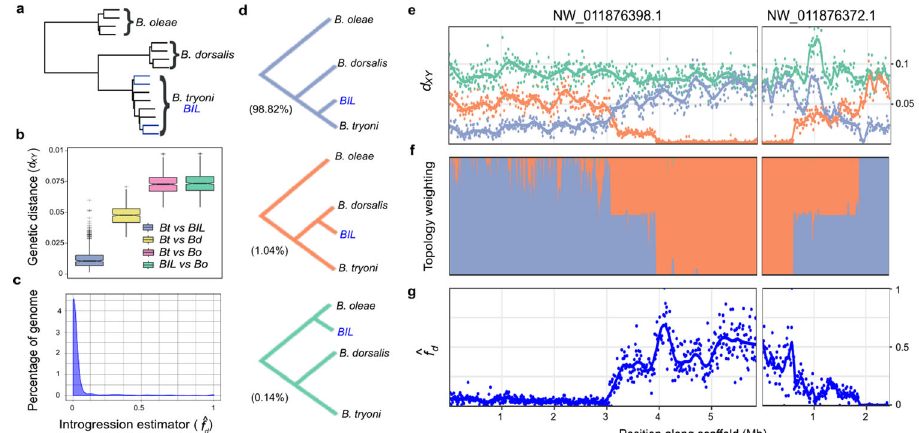
Fig. 1 Characterization of total introgression from B. dorsalis into the Bactrocera introgressed line and identi fi cation of the white pupae locus. a Species tree constructed from 1846 single copy ortholog gene trees for four haplotypes of B. oleae, B. dorsalis, B. tryoni , and BIL . Branches corresponding to BIL individuals are shown in blue. All nodes were well supported with posterior probabilities >0.97. b Nei ’ s absolute genetic distance ( d XY ) calculated for tiled 100 kb windows across the genome between B. tryoni vs BIL ( Bt vs BIL); B. tryoni vs B. dorsalis ( Bt vs Bd ) ; B. tryoni vs B. oleae ( Bt vs Bo ); and BIL vs B. oleae ( BIL vs Bo ). Box and whisker graphs (including outliers) represent a summary of 2294 genomic windows. Boxes show the fi rst and third inter quartile range (IQR) while whiskers extend to a maximum of 1.5 ∗ IQR. All values outside 1.5 ∗ IQR are shown as plus signs. c The introgression estimator ( ƒ d ) calculated across tiled 100 kb windows to identify regions of disproportionately shared alleles between BIL and B. dorsalis , ƒ d ( Bt , BIL , Bd ; Bo ). d The three evolutionary hypothesis/topologies of interest to identify introgressed regions and their representation across the genome: species (purple, 98.82%), introgression (orange, 1.04%) and a negative control tree (green, 0.14%). e Nei ’ s absolute genetic distance ( d XY ) calculated for tiled 10 kb windows across the